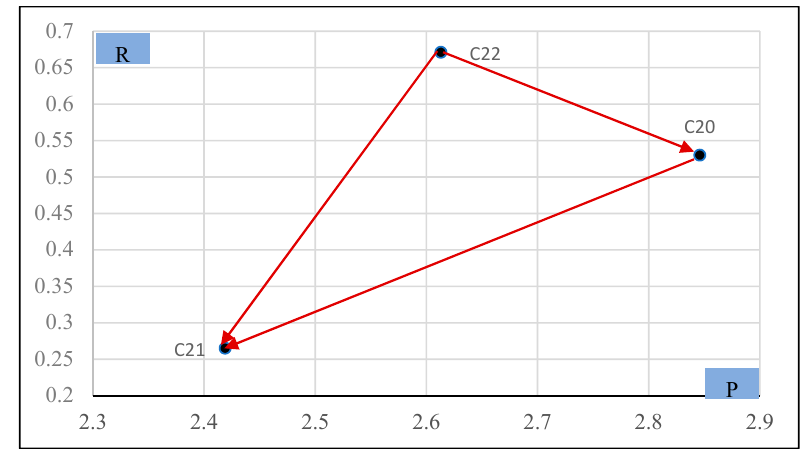
( f ) The cause–effect diagram of managing risk factors. Figure 5. The cause–effect diagram of the dimensions ( a ) and criteria of ( b ) pollical/legal risk, ( c ) economic/market risk, ( d ) social/environmental risk, ( e ) project/technical risk, and ( f ) managing risk.